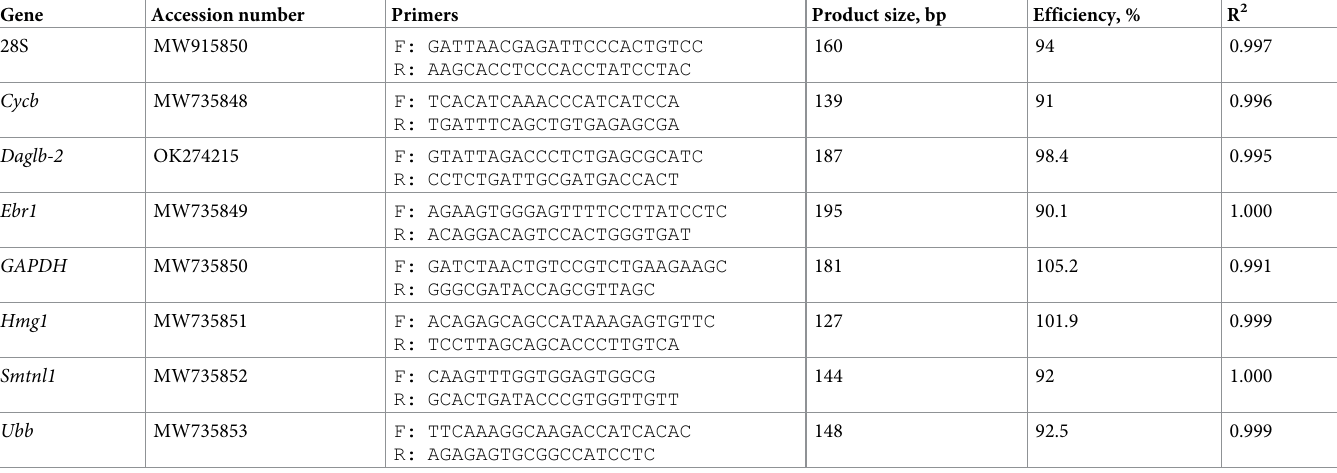
Table 2. Names of genes, primers used for RT-qPCR and reaction efficiency.